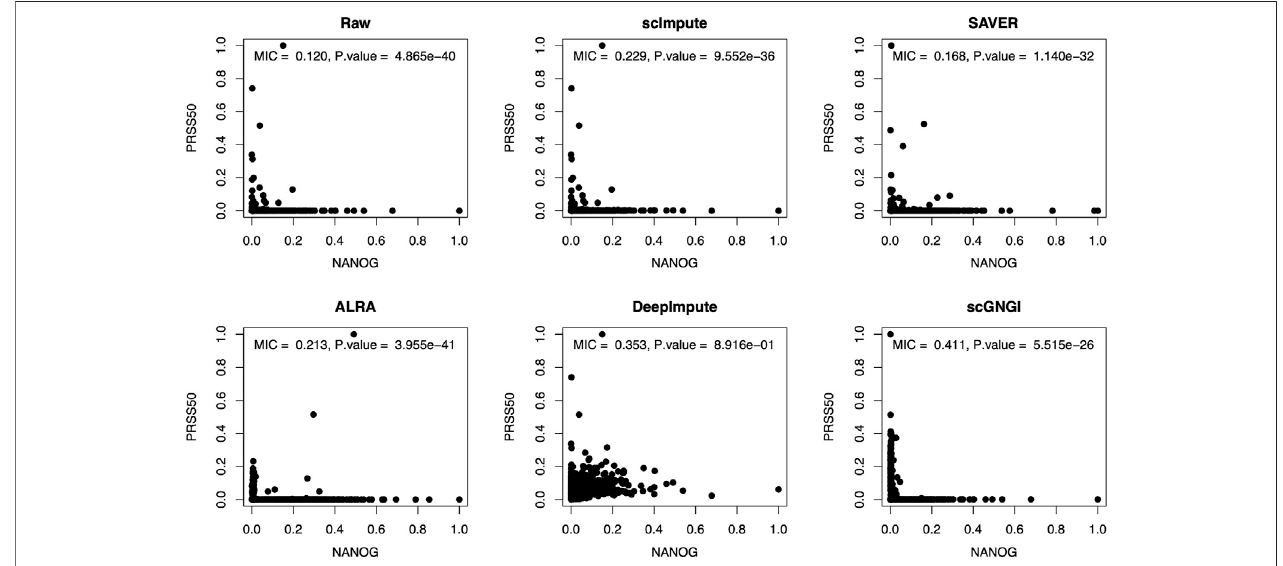
FIGURE 7 | Scatter plots of the expression levels between marker genes (NANOG and PRSS50) in the raw and imputed data by using different methods. On the top, the corresponding maximal information coef fi cient (MIC) and p value are shown for gene expression values. The two-sided Wilcoxon rank-sum test is used for p values. Each dot represents a cell.